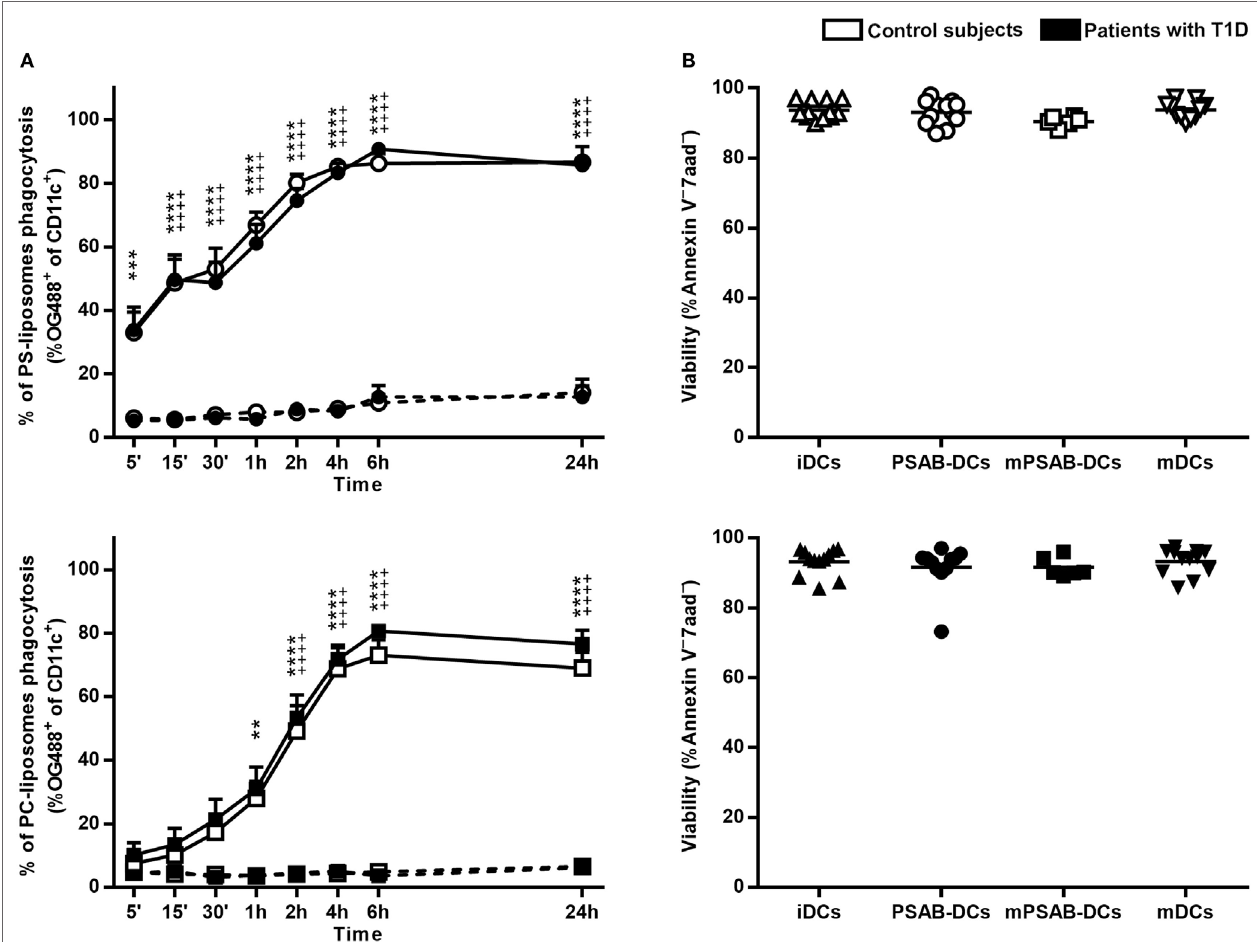
FigUre 2 | Liposomes are efficiently phagocyted by dendritic cells (DCs) and preserve a high viability. (a) Uptake of liposomes fluorescently labeled with lipid-conjugated fluorescent dye Oregon Green 488 1,2-dihexadecanoyl-sn-glycero-3-phosphoethanolamine by DCs. Upper panel: time course of the capture of fluorescently-labeled PS-liposomes by DCs obtained from control subjects (white circles, n = 5) and patients with type 1 diabetes (T1D) (black circles, n = 10) at 37°C (continuous line) and at 4°C (discontinuous line). Results are mean ± SEM. Comparisons between phagocytosis by control subjects DCs at 37 and 4°C showed significant differences [ ++++ p < 0.0001, two-way analysis of variance (ANOVA)]; also, significant differences were found when comparing phagocytosis in patients with T1D at 37 and 4°C (*** p < 0.001, **** p < 0.0001, Two-way ANOVA). No differences were found when comparing PS-liposomes uptake by DCs from control subjects and patients with T1D (Two-way ANOVA). Lower panel: time course of the capture of fluorescently-labeled PC-liposomes by DCs obtained from control subjects (white squares, n = 6) and patients with T1D (black squares, n = 9) at 37°C (continuous line) and at 4°C (discontinuous line). Results are mean ± SEM. Comparisons between phagocytosis by control subjects DCs at 37 and 4°C showed significant differences ( ++++ p < 0.0001, Two-way ANOVA); also, significant differences were found when comparing phagocytosis in patients with T1D at 37 and 4°C (** p < 0.01, **** p < 0.0001, Two-way ANOVA). No differences were found when comparing PC-liposomes uptake by DCs from control subjects and patients with T1D (Two-way ANOVA). (b) Viability of DCs from control subjects (upper panel, white symbols, n ≥ 6) and patients with T1D (lower panel, black symbols, n ≥ 6) assessed by annexin V and 7aad staining. Triangles represent immature DCs (iDCs), circles represent iDCs cultured with PSA-liposomes and PSB-liposomes (PSAB-DCs), squares represent mature PSAB-DCs (mPSAB-DCs) and upside-down triangles represent mature DCs (mDCs). MDCs were induced by culture with cytokine